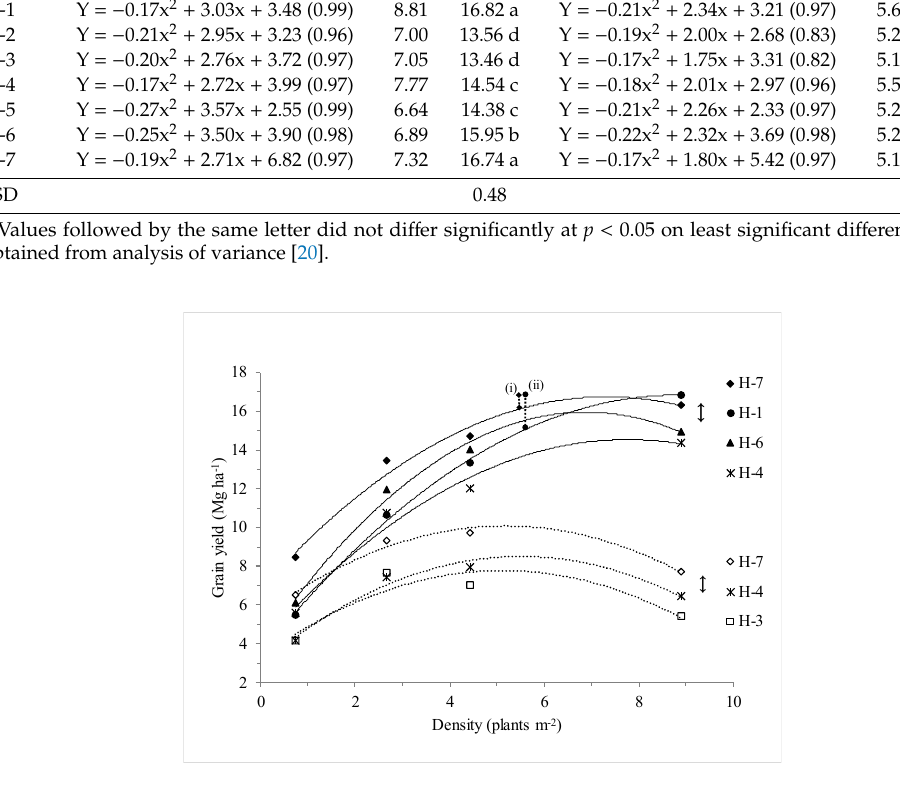
Table 1. The quadratic grain yield response to density (in parenthesis the coefficient of determination, R2), and the respective optimum density (OD, plants/m 2 ) and attainable crop yield (ACY, Mg/ha) of seven hybrids. Data from Mylonas et al. [28] obtained under four densities across five sites at the normal irrigation regime (NIR) and the low irrigation regime (LIR).